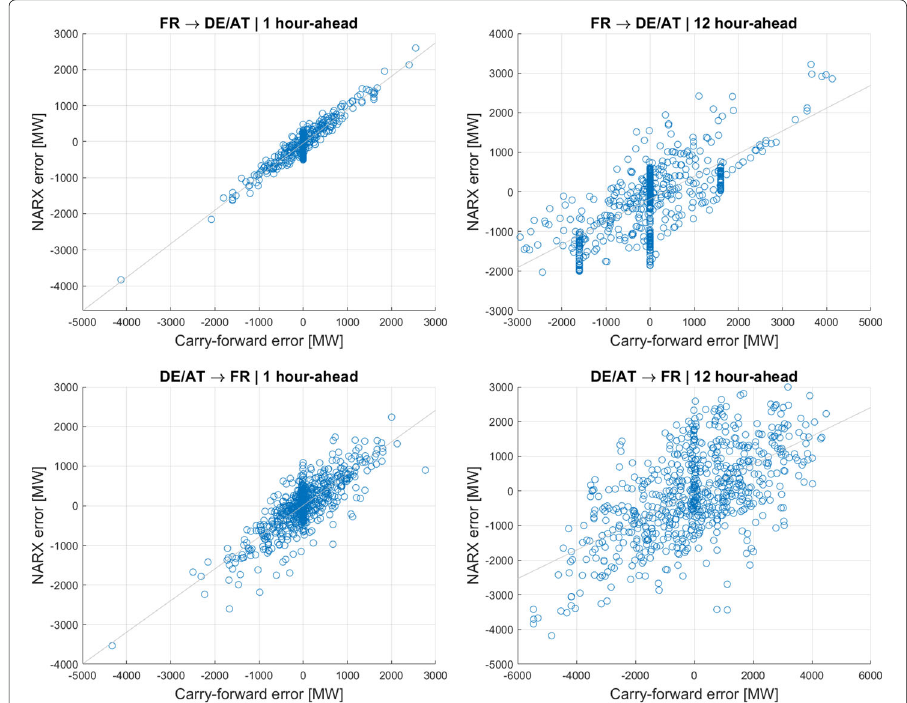
Fig. 5 Error per time step for one-hour forecast (left) and twelve-hour forecast (right) for the link FR → DE/AT (top) and the link DE/AT → FR (bottom). The x-value and the y-value of each point represents the difference between the real value and the predicted value at a certain time according to the carry-forward method and the NARX network,